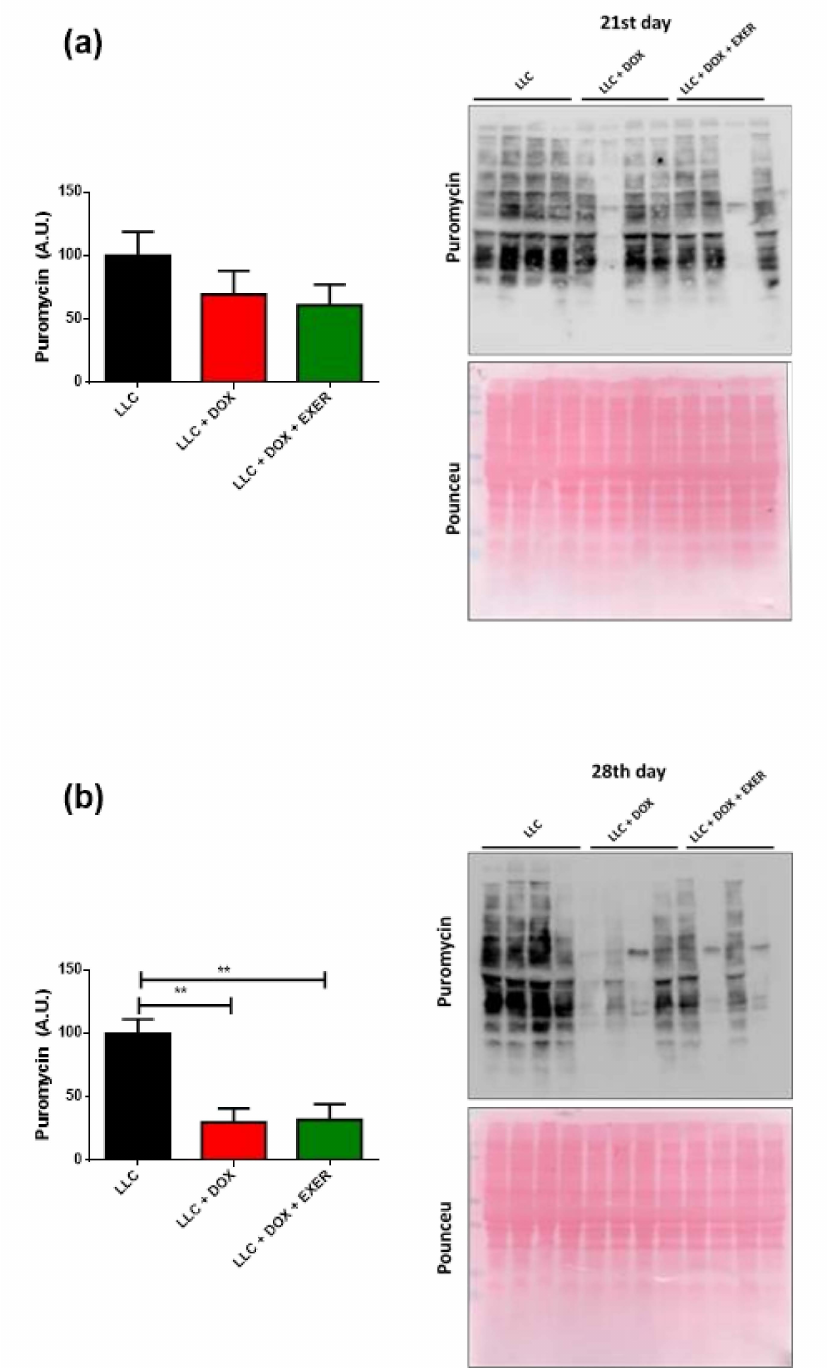
Figure 5. Evaluation of total protein synthesis immediately after and one week post-chemotherapy. ( a ) Total protein synthesis in the gastrocnemius muscle evaluated by the SUnSET assay at the end of the chemotherapy cycle; ( b ) total protein synthesis in the gastrocnemius muscle evaluated by the SUnSET assay after the suspension of chemotherapy. Values represent the mean and standard error of the mean of the analysis of the data obtained. n = 4. ** p < 0.01. LLC = Lewis lung carcinoma; DOX = doxorubicin; EXER = endurance exercise. The uncropped Western Blots are available in Figure